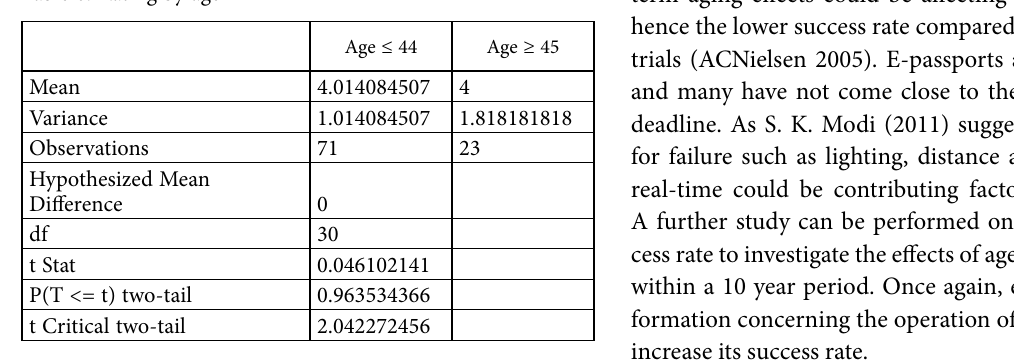
Table 6. Rating by